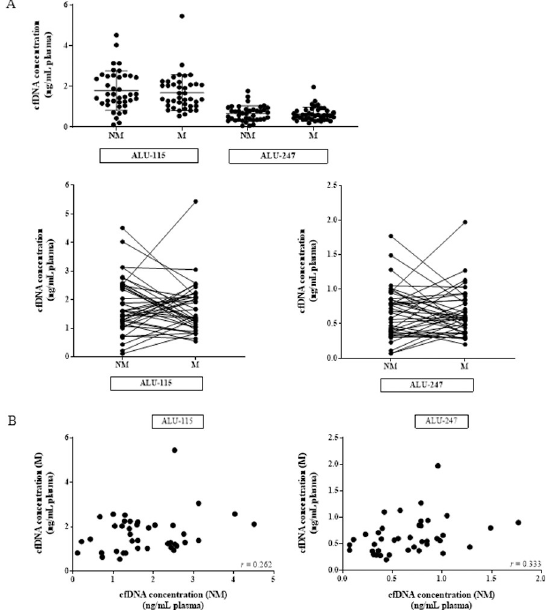
Fig 1. Total cfDNA does not increase during menstruation. (A) Total cfDNA quantification in 40 healthy women at NM and M phases by qPCR, expressed in ng of cfDNA per 1 mL of plasma (ALU-115 p = 0.273; ALU-247 p = 0.385). (B) Scatter plot of NM ALU-115 and M ALU-115 (r = 0.262; p = 0.0516) as well as NM ALU-247 and M ALU-247 (r = 0.333; p =